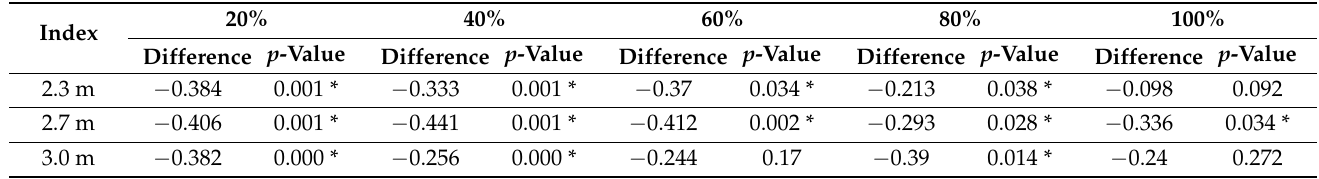
Table 6. Analysis of difference between ceiling height and window ratio RAB indicators of aspect ratio